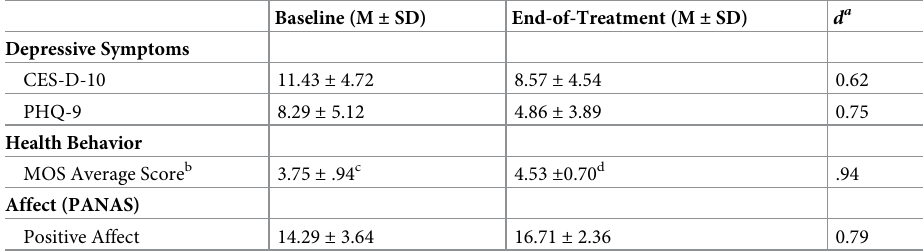
Table 4. Mood, affect, and health behavior at baseline and end-of-treatment for completers (n =